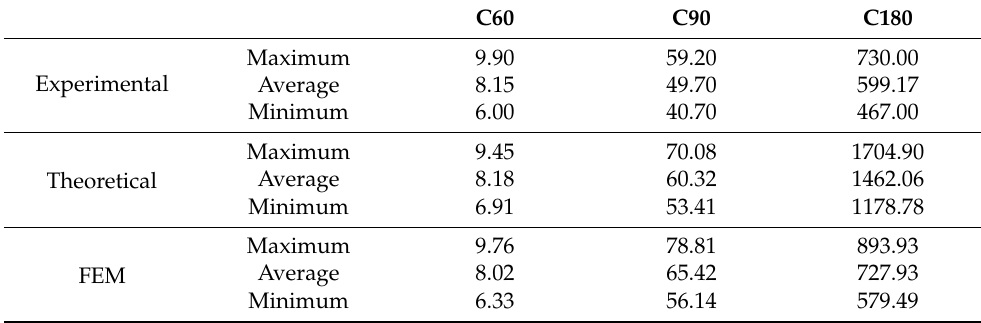
Table 3. Comparative results of the three cross-sections. Including average, maximum, and minimum results of experimental tests, FEM model, and theoretical approach. Unit in